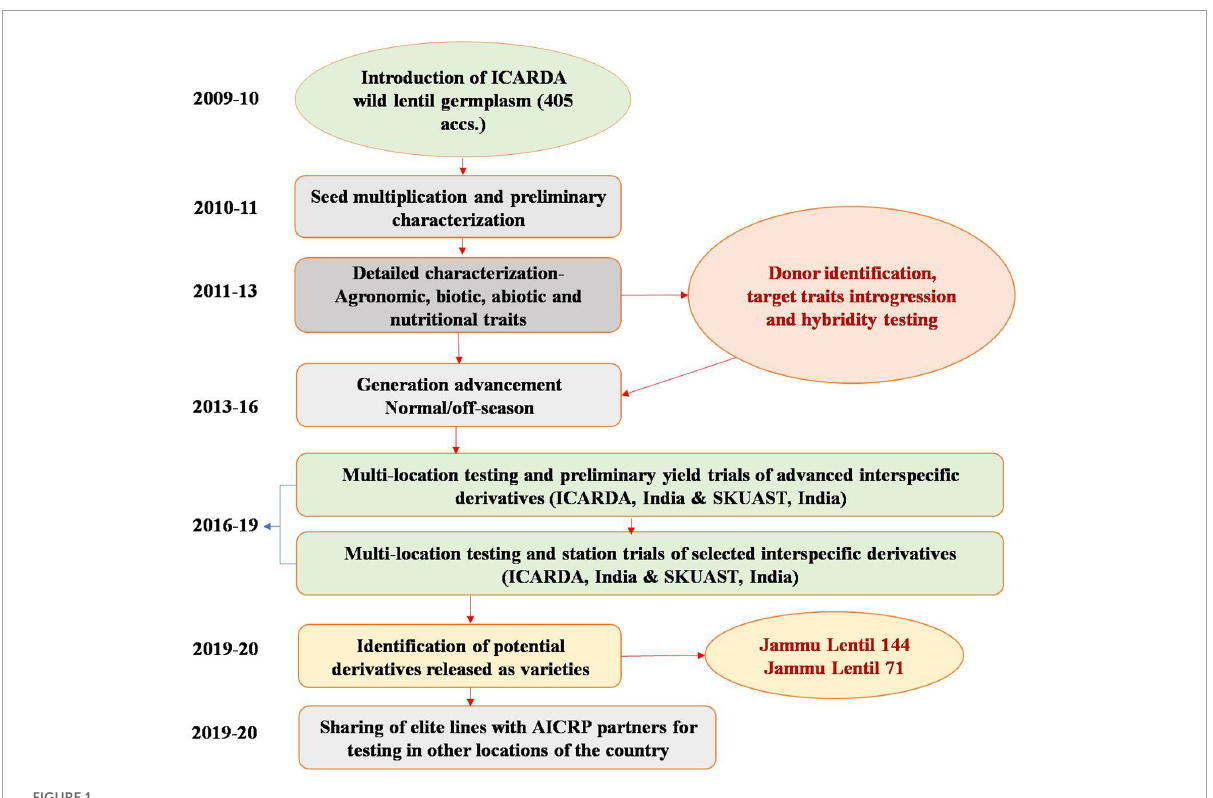
Mean rainfall Temperature ( ◦ C) Soil type (m) (mm) Min Max Black